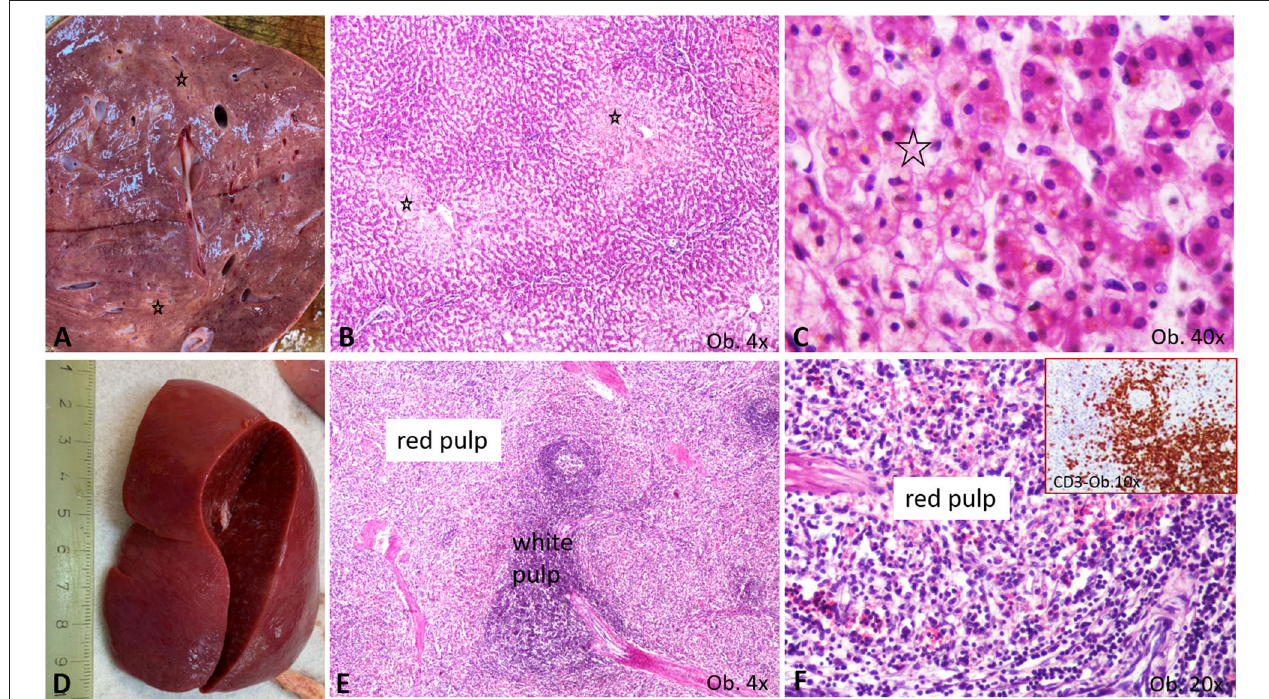
FIGURE 4 | Gross and microscopic features of liver and spleen. (A–C) Liver centrilobular fatty change, with pale macro- (A) and microscopic area (B) , which show a multivacuolar aspect, at high power view (C) , being marked by *; (D–F) Splenomegaly specimen (D) is characterized by enlargement of the white pulp (E) , with T cell-rich aspect of the red pulp (F) , proved by the CD3 positivity ( F